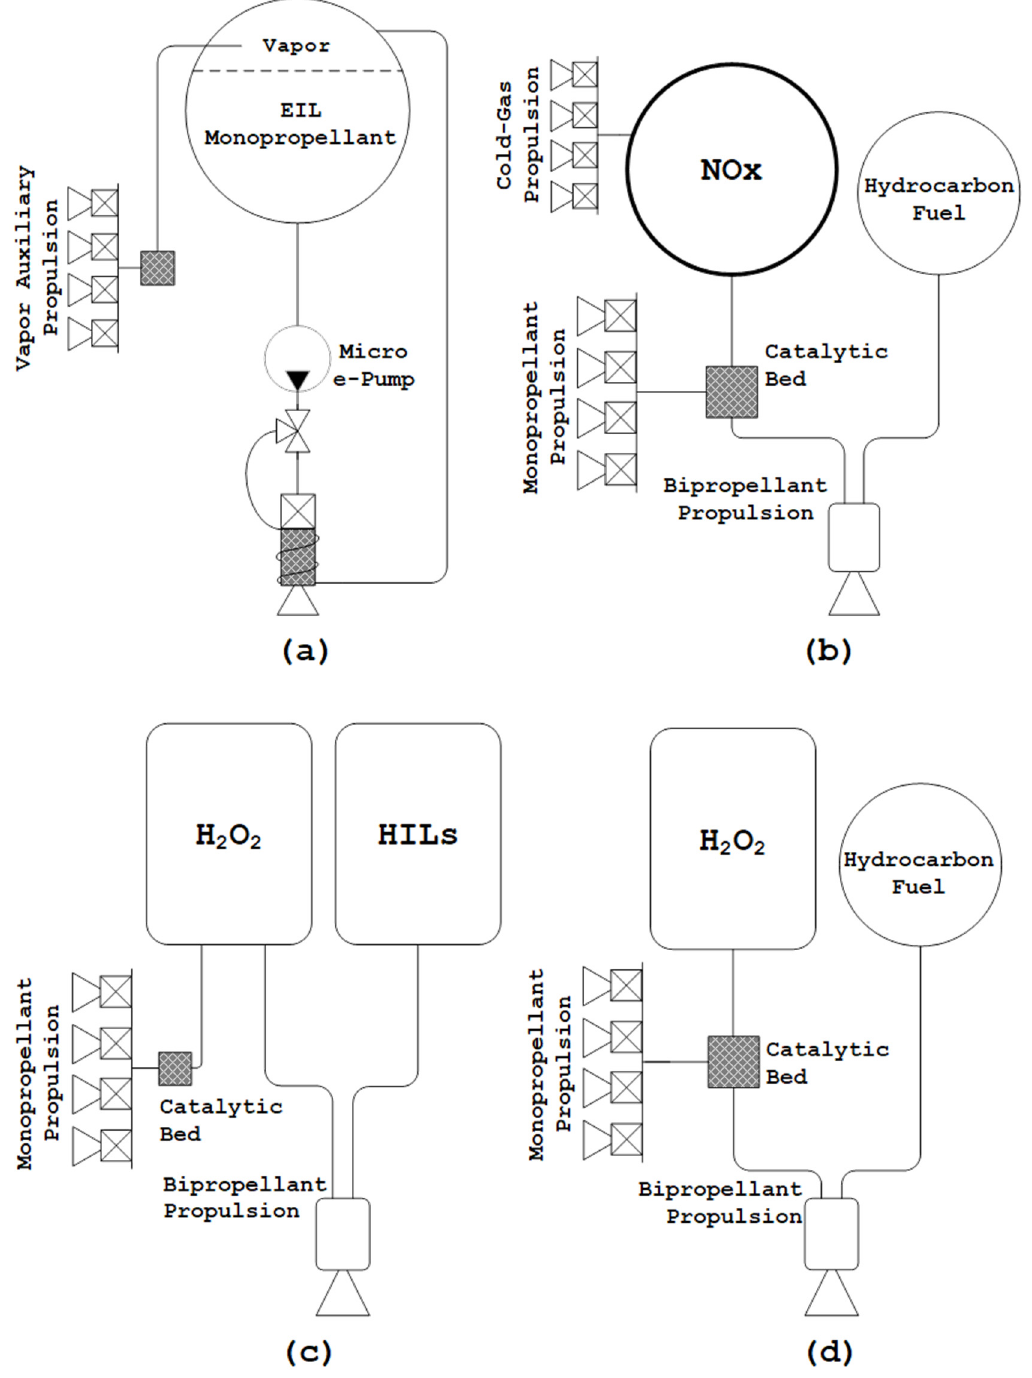
Figure 1. Green monopropellants in “multi-mode” propulsion systems: ( a ) Energetic Ionic Liquids (EIL) in micro e-pump-fed autogenously-pressurized primary propulsion system for CubeSat with auxiliary (RCS) vapor propulsion system—(MIMPS-G); ( b ) nitrous oxide with hydrocarbon fuels bipropellant propulsion system with the possibility to incorporate auxiliary propulsion systems of cold-gas or catalytically decomposed monopropellant propulsion; ( c ) ionic liquid fuel hypergolically ignited by hydrogen peroxide bipropellant propulsion system, the H 2 O 2 can act as fuel for a catalytically decomposed monopropellant auxiliary propulsion system for reaction and attitude control; ( d ) hydrogen peroxide as monopropellant and as oxidizer for hydrocarbon fuels in a hypergolically ignited propulsion system as well as (RCS) in a launcher upper-stage.